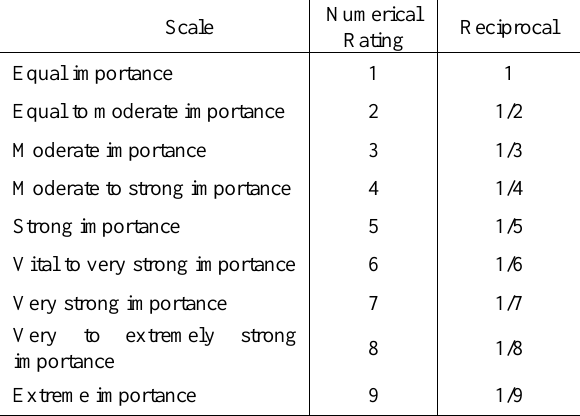
Table 4 . Pairwise comparison scales in AHP (Kunasekaran and Kannan, 2014).